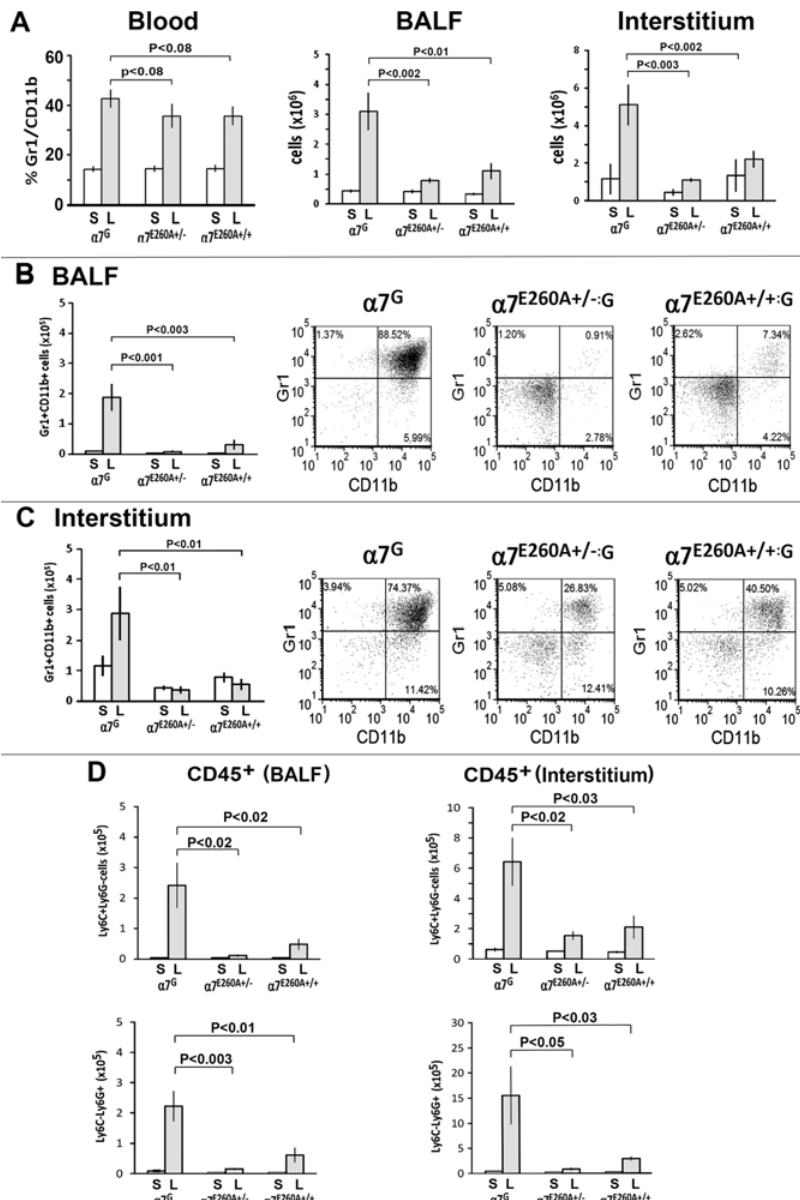
Fig 4. The response of α 7 G , α 7 E260A:G heterozygote and α 7 E260A:G homozygote mice to i.n. LPS challenge. Mice ( α 7 G , heterozygote α 7 E260A+/-:G or homozygote α 7 E260A+/+:G ) were challenged with i.n. LPS (250 μ g/mouse in 30 μ l Saline) or saline (30 μ l per mouse). For all experiments the results are shown as scatter plots and quantitated with bar graphs reflecting the results of three independent experiments (4 to 5 mice per experimental group). Error bars represent standard error of the mean (SEM) and statistical significance was determined using the Student ’ s t-test. (A) a small sample of blood (50 μ l) was collected 24 hours LPS post-challenge and assessed for CD11b + Gr1 + cells (left panel). On day 3 after challenge, mice were sacrificed and BALF and interstitial cells isolated as described above and in the Methods for determination of total number of nucleated cells (A, middle and right panels). (B) BALF cells and (C) interstitial CD45 + cells isolated at 72 hrs post-challenge from α 7 G , α 7 E260A+/-:G, α 7 E260A+/+:G . (D) BALF and interstitial CD45 + cells are shown and further identified by markers for monocyte/macrophages (Ly6C) and PMN (Ly6G).